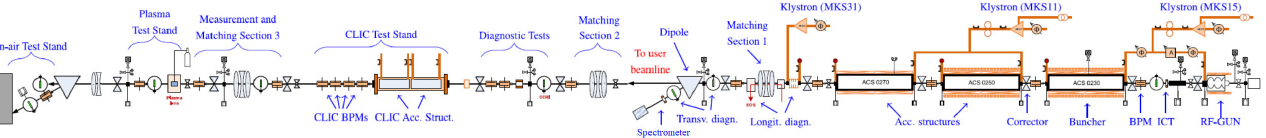
FIG. 1. The CLEAR beamline (from right to